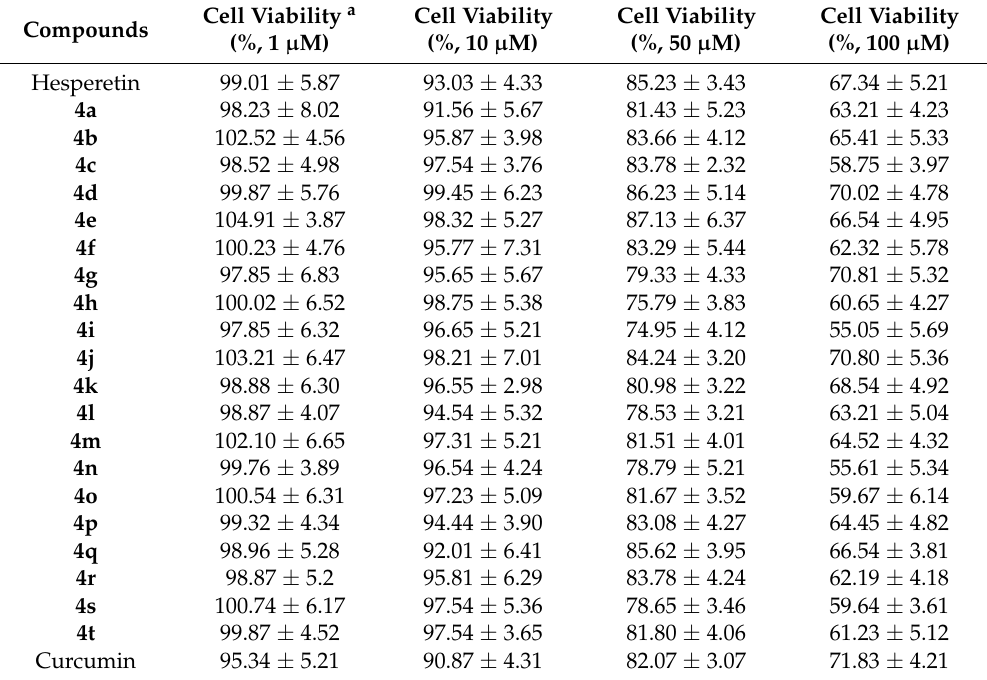
a Cell viability: Data are expressed as percent of positive control. Data show mean ± SD for three independent experiments.